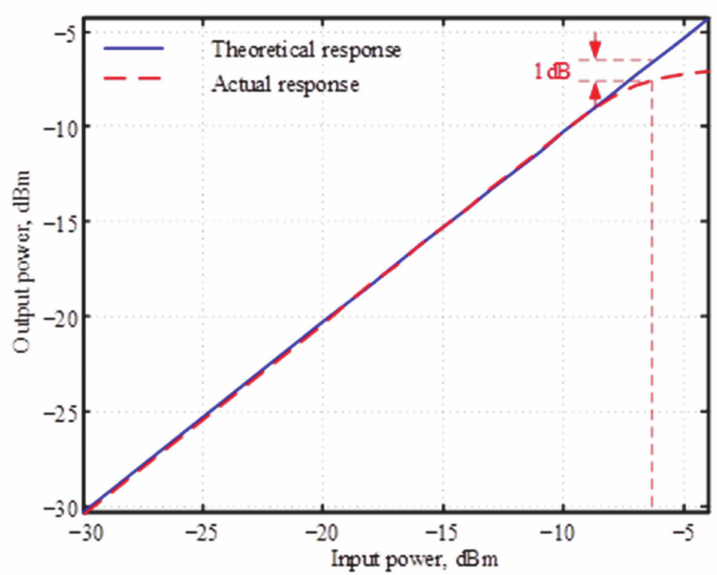
Figure 20. The measurement of P1dB at the V o2 output terminal.